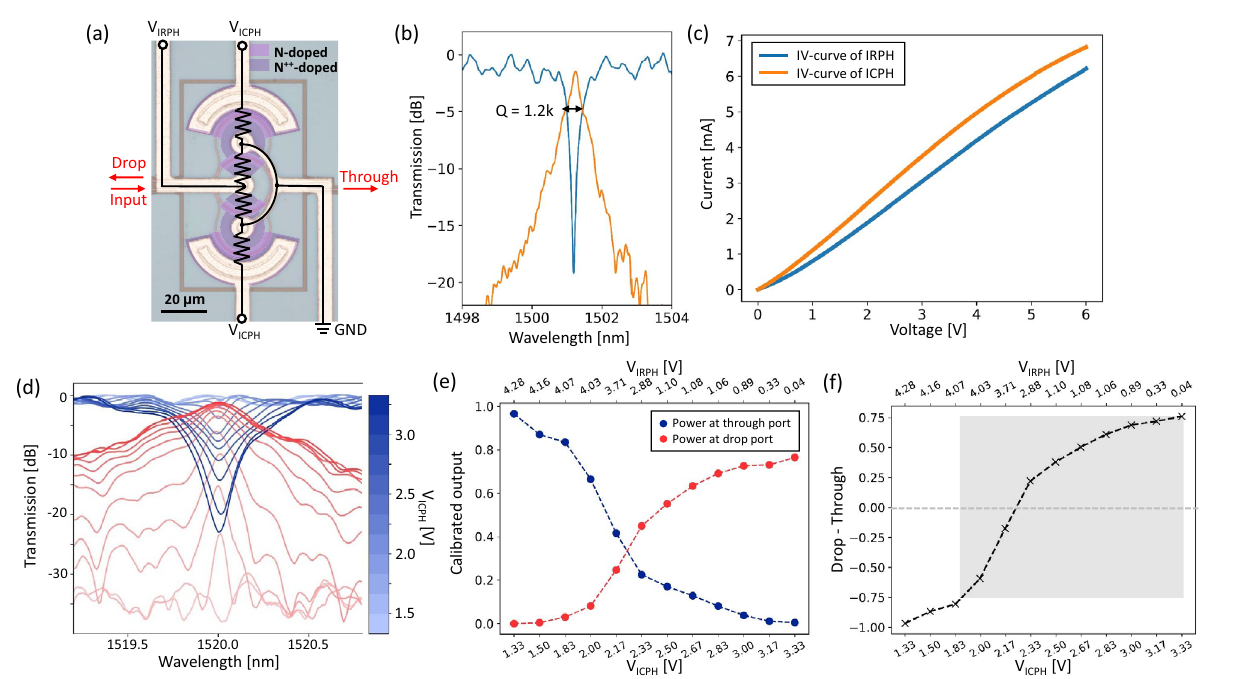
Figure 5. ( a ) Microscopic image of the add-drop IM-MRR weight filter design overlaid with a circuit description of the integrated ICPH and IRPH. ( b ) Measured normalized transmission spectra at through (blue) and drop (orange) ports. ( c ) Measured IV curve for one of the ICPH and IRPH voltage pairs changing from 0 to 6 V. ( d ) Measured normalized transmission at through (blue) and drop (red) ports for intensity modulation at 1520 nm. ( e ) Calibrated outputs of the add-drop IM-MRR at the resonant peak. ( f ) Measured weight range from the subtraction between the calibrated output at drop and through ports. The grey region represent the symmetrical range relative to